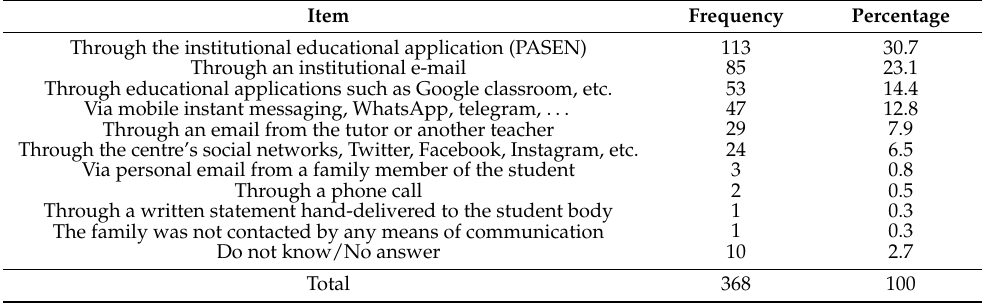
Table 3. Communication channels through which families have been contacted by the centres during the health crisis. Item Frequency Percentage Through the institutional educational application (PASEN)